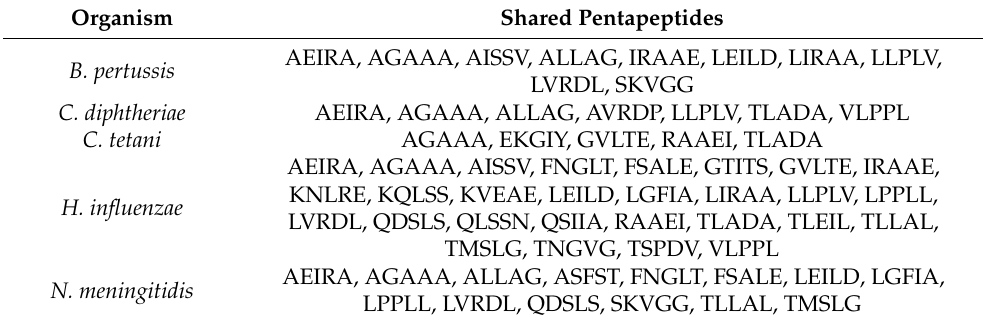
Table 4. Pentapeptides occurring in microbial organisms and common to the SARS-CoV-2 spike gp, SARS-CoV-2 spike gp-derived epitopes, and anti-inflammatory proteins.